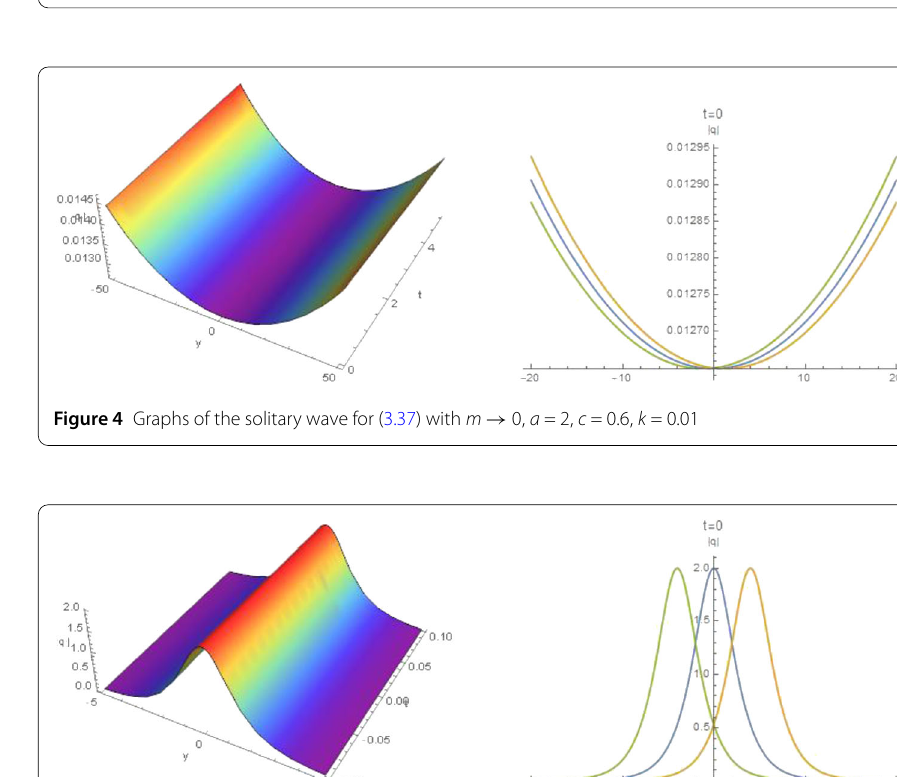
Figure 3 Graphs of the solitary wave for (3.34) with m → 1, a = 2, c = 0.6, k = 0.01